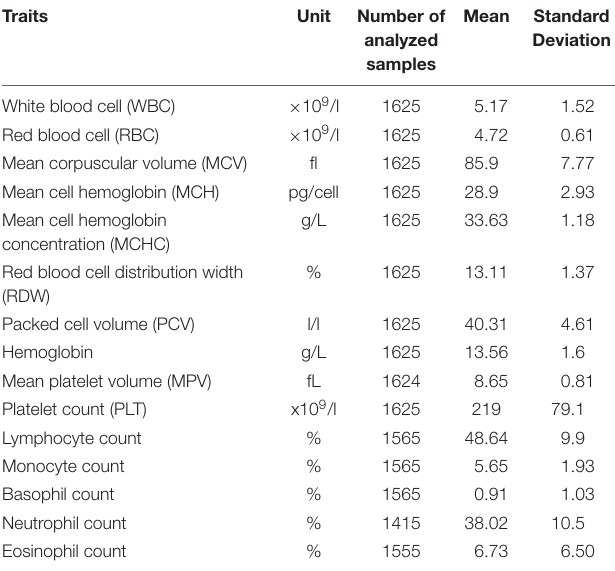
TABLE 1 | A description of phenotypic traits analyzed in the total 6407 individuals in the pooled dataset.